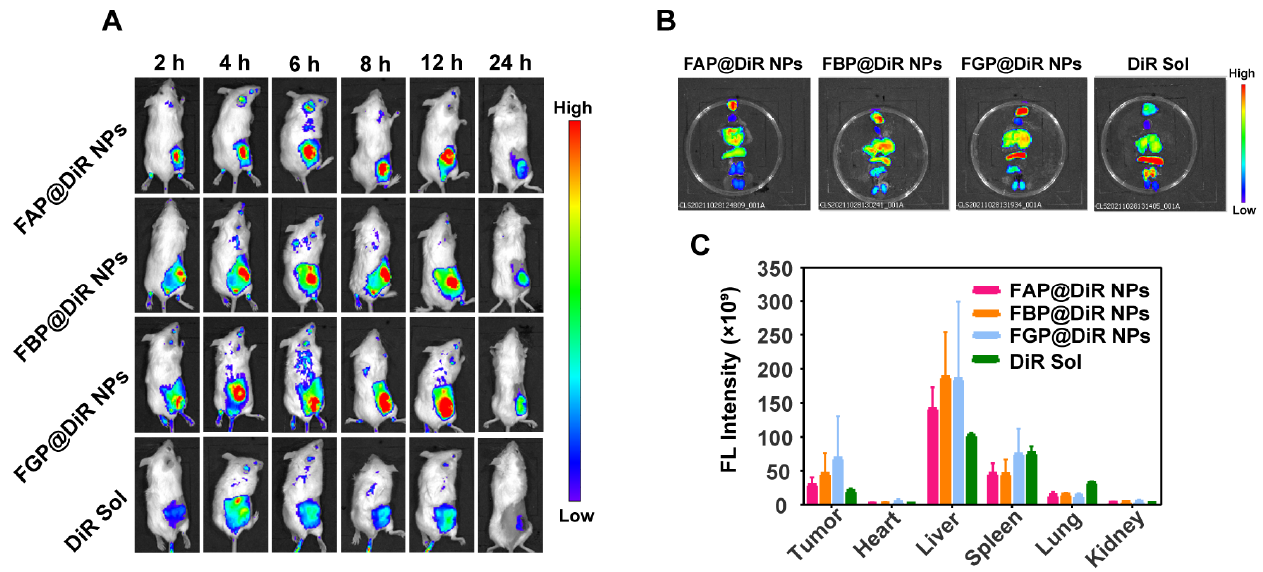
Figure 6. Biodistribution of prodrug NPs in 4T1 tumor-bearing mice. ( A ) In vivo whole-body DiR fluorescence imaging of mice 24 h after i.v. injection of DiR-labeled prodrug NPs and DiR solution. ( B ) DiR fluorescence imaging of major organs and tumors excised from the mice. Tumor, heart, liver, spleen, lung and kidney were arranged from top to bottom. ( C ) Quantitative analysis of fluorescence intensities in the tumor region and major organs at 24 h post